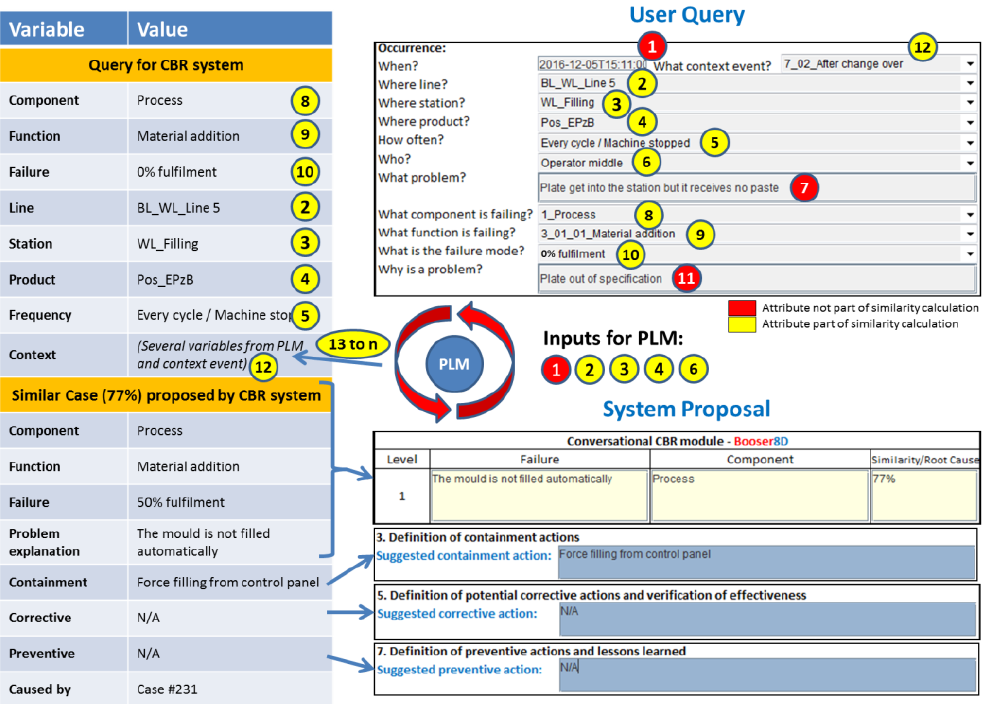
Figure 9. Information match between application user interface and the knowledge model.